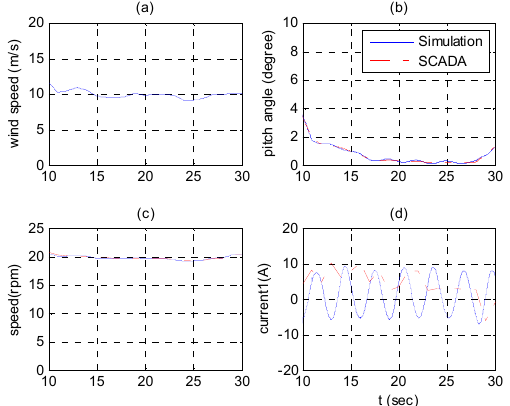
Figure 16. Pitch subsystem comparison of 2 MW wind turbine: ( a ) Input wind; ( b ) Pitch angle; ( c ) Rotor speed; and ( d ) Motor current.